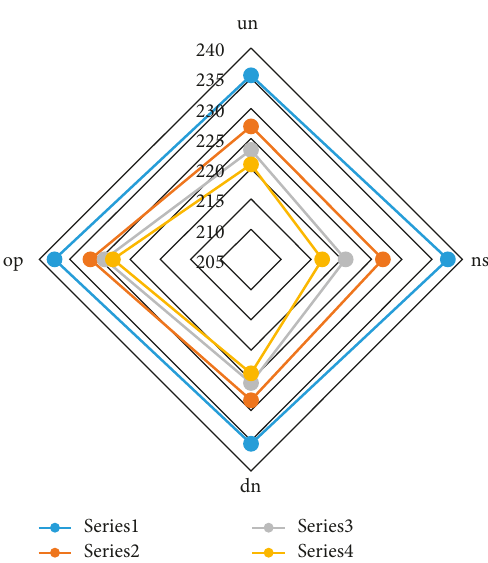
Figure 5: Effect of parameters with LFFWHM.